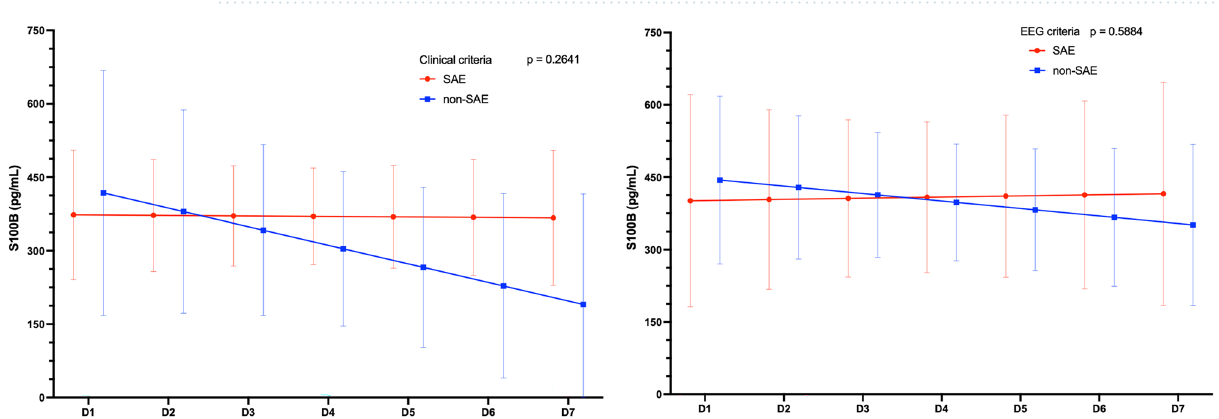
Figure 2. Temporal curves of predicted means of the Neuron-Specific Enolase (NSE) biomarker in the groups with and without clinical criteria (on the lower left) and with and without ECG criteria (on the lower right) for sepsis-associated encephalopathy in the first seven days after the diagnosis of sepsis.